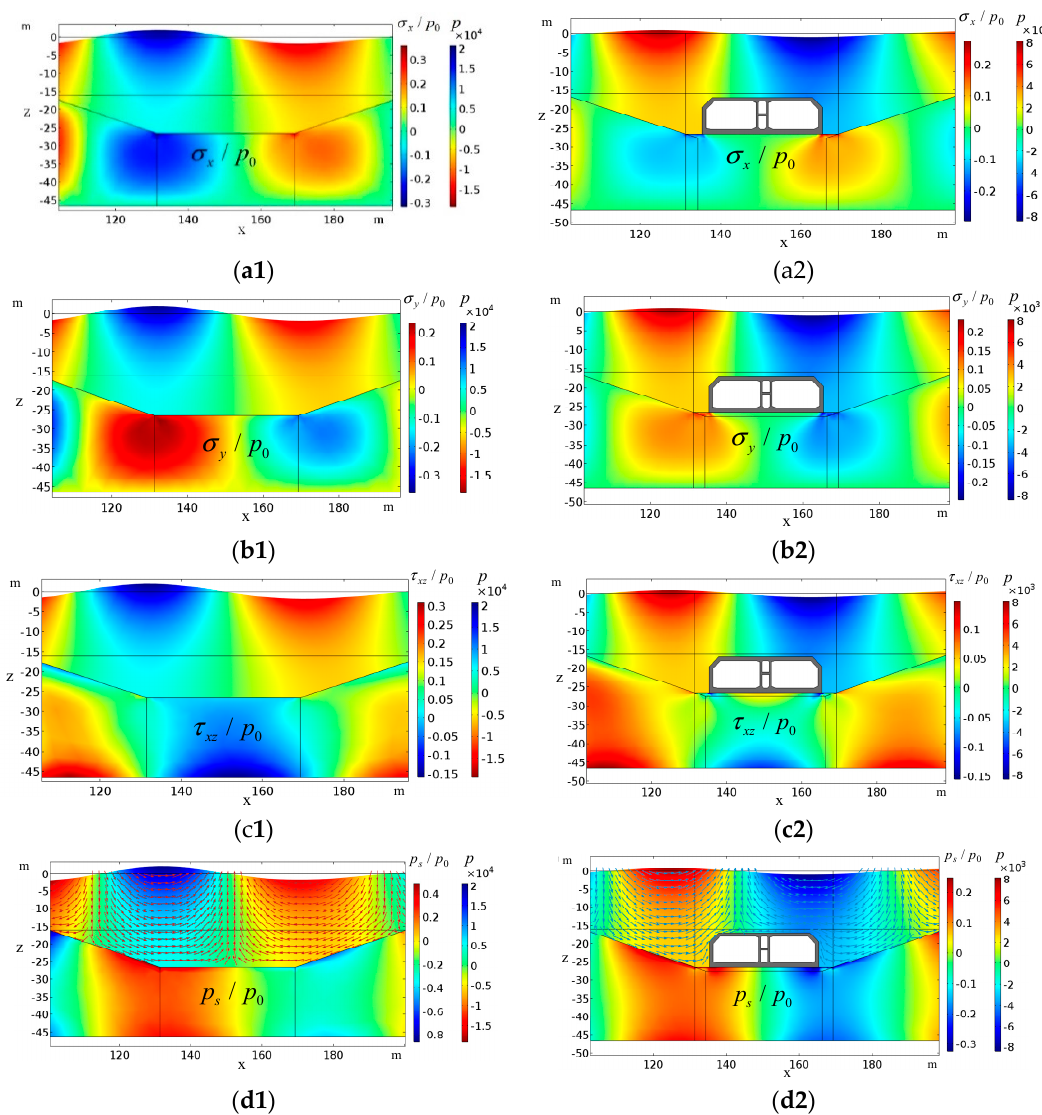
Figure 7. The distribution of ( a ) σ x / p 0 , ( b ) σ y / p 0 , ( c ) τ xz / p 0 , ( d ) p s / p 0 in two cases: after the foundation groove is excavated ( t = 29 s) and after the tunnel element is placed ( t = 29 s). ( p 0 is the water pressure at the seabed surface.)